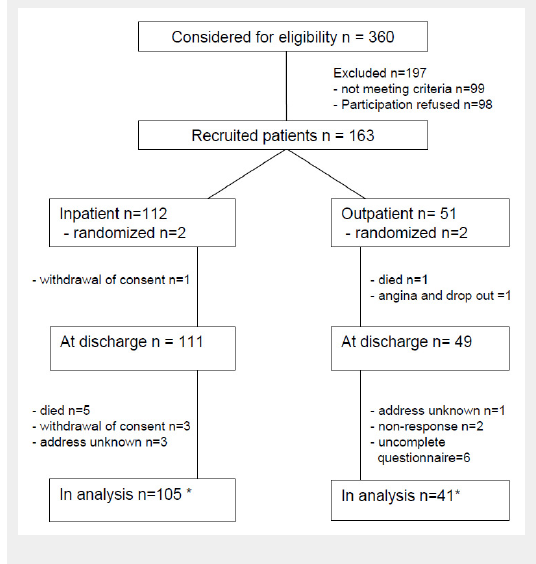
Patient flow. all patients aged 30–65 with acute coronary syndrome (ACS) at day 2 to 5 after ACS during the study period were considered for